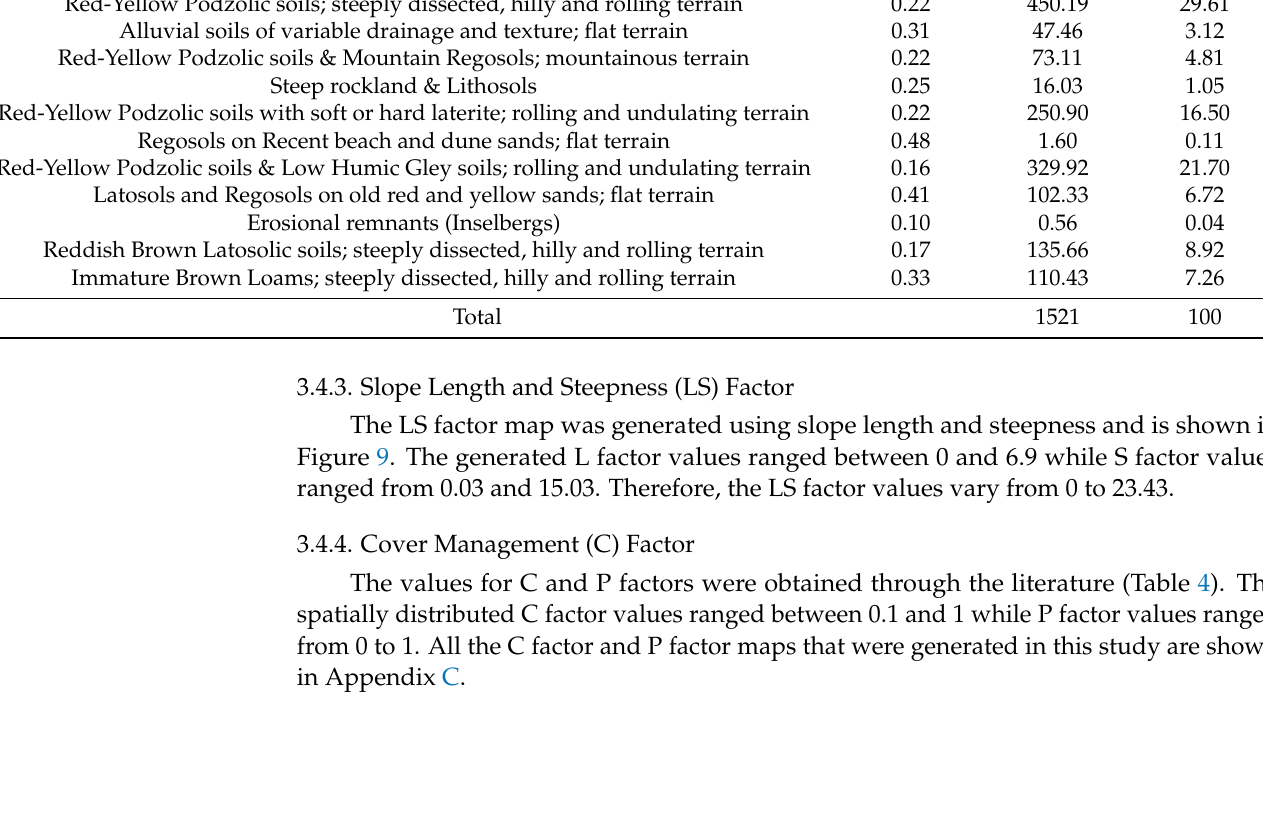
Table 9. Soil erodibility factors and area percentage of soil types in Maha Oya River Basin. Soil Type K Factor Area (km 2 ) Area (%) Rock knob plain